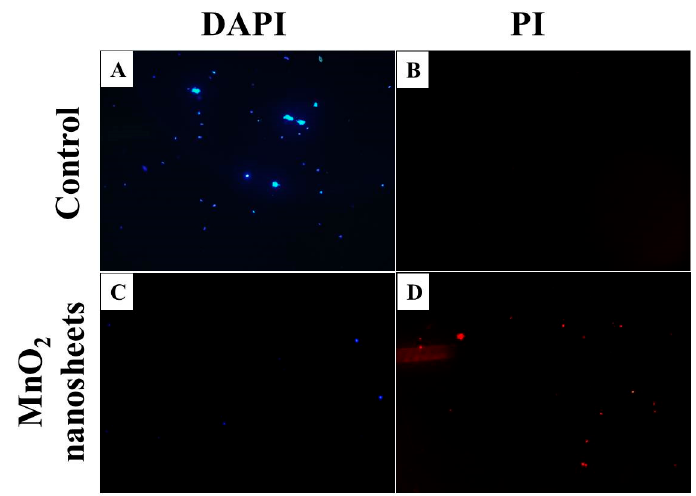
Figure 5. Fluorescence assays of live and dead Salmonella cells in the absence ( A , B ) and presence ( C , D ) of 125 μ g/mL MnO 2 nanosheets.